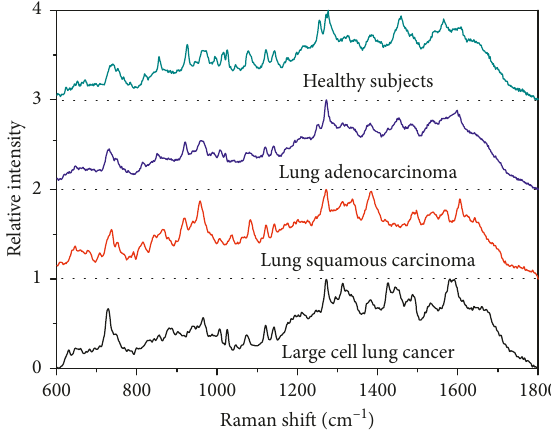
Figure 5: The normalized mean SERS spectra of serum obtained from (black curve) large cell lung cancer patients, (red curve) lung squamous carcinoma patients, (blue curve) lung adenocarcinoma patients, and (green curve) healthy